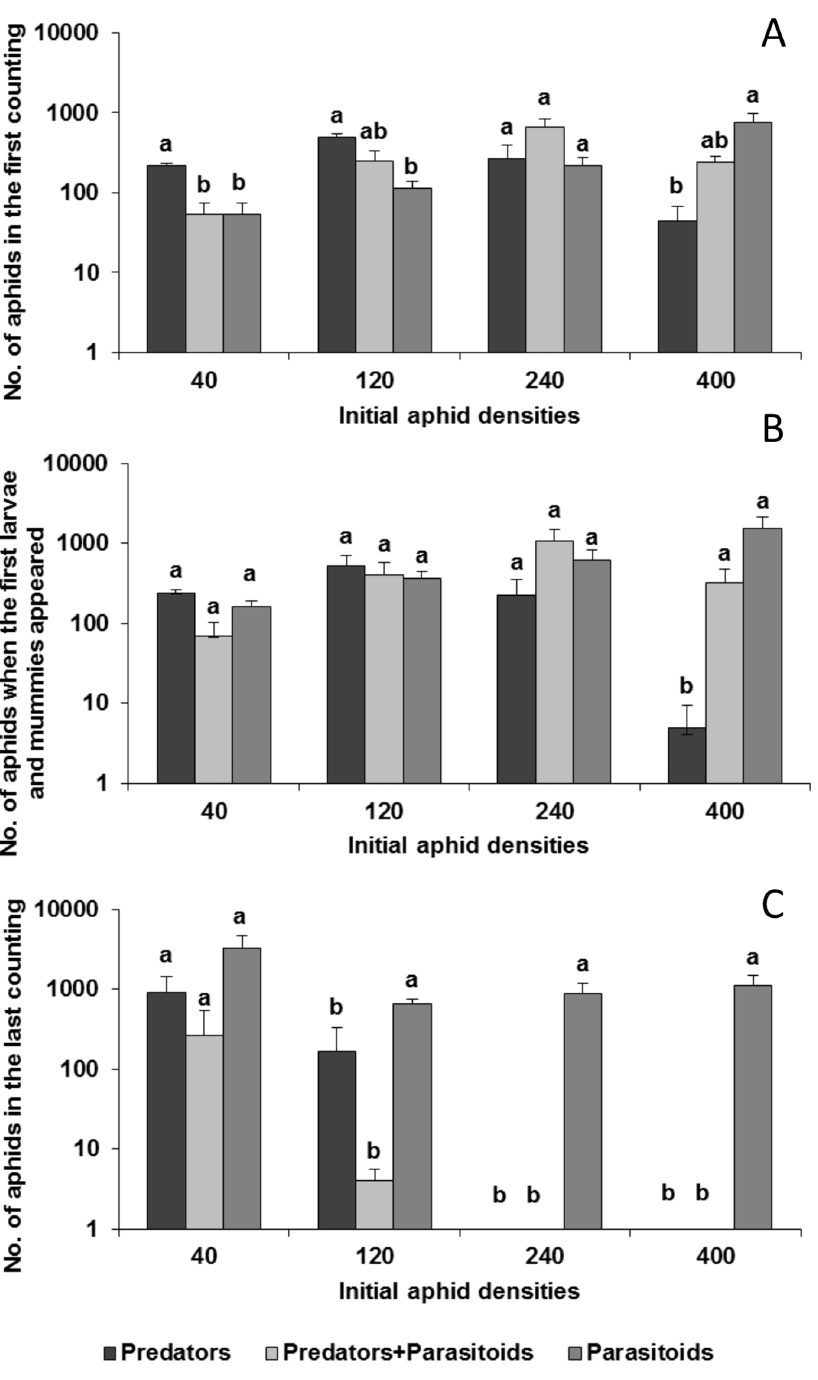
Figure 2. Average ( ± SE) number of aphids recorded at the first count (A), at the instant when the first mummies and larvae appeared (B) and in the last count (C). For each of the initial number of aphids used (40, 120, 240, 400 - indicated on the horizontal axis), different letters represent differences between the means recorded in the different sub-treatments.